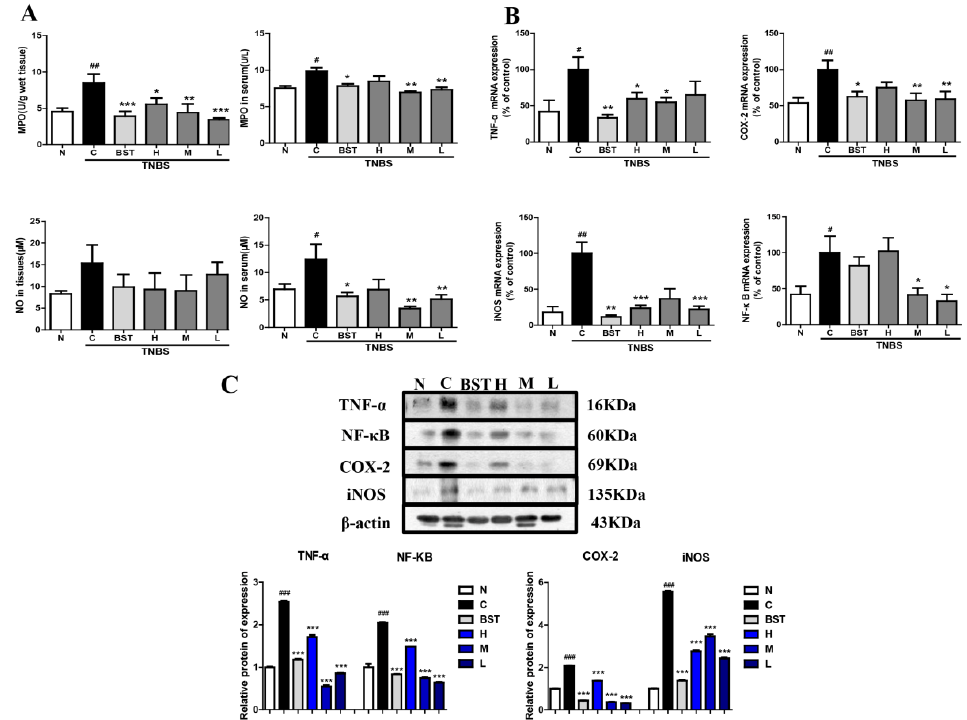
Figure 3. Inhibitory effects of CAL on the pro-inflammatory cytokine production of TNBS-induced IBD rats. ( A ) Nitric oxide (NO) and myeloperoxidase (MPO) content in serum and colon tissue. ( B ) The mRNA expressions of pro-inflammatory cytokines in colon tissue. ( C ) The protein expressions of pro-inflammatory cytokines in colon tissue. N: normal group; C: TNBS alone group; BST: balsalazide 1 g/kg + TNBS group; H: CAL 500 mg/kg + TNBS group; M: CAL 250 mg/kg + TNBS group; L: CAL 125 mg/kg + TNBS group; n = 8, # p < 0.05, ## p < 0.01, ### p < 0.001 vs. normal group; * p < 0.05, ** p < 0.01, *** p < 0.001 vs. TNBS group. Data (mean ± SEM) were analyzed by ANOVA.